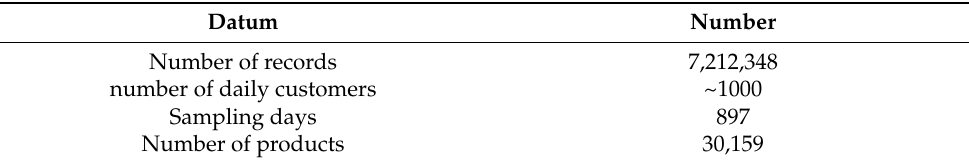
Table 1. Statistics of the